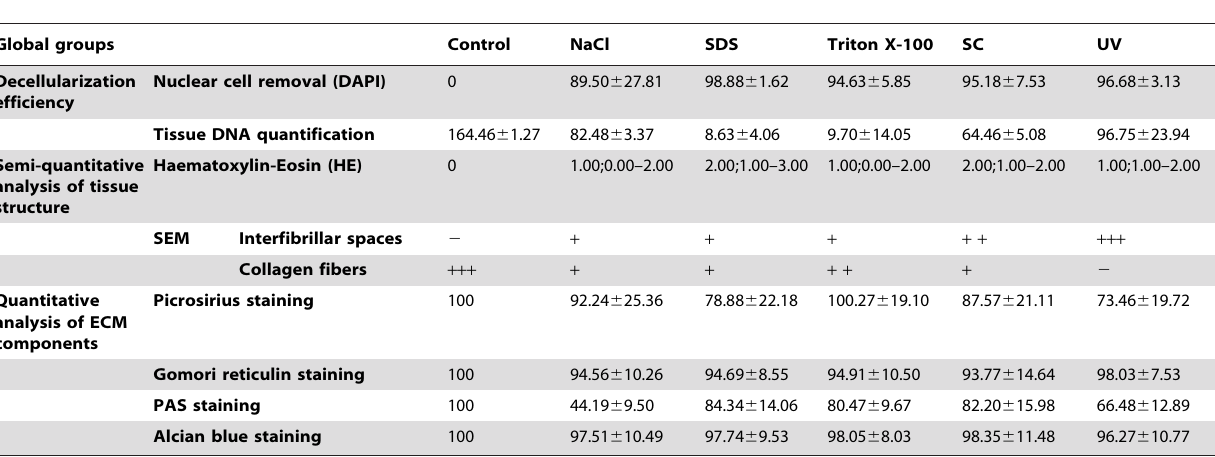
Table 1. Average results of the evaluation of decellularization efficiency, semi-quantitative analysis of tissue structure and quantitative analysis of fibrillar and non-fibrillar ECM components in control non-decellularized intestine and in all decellularization global